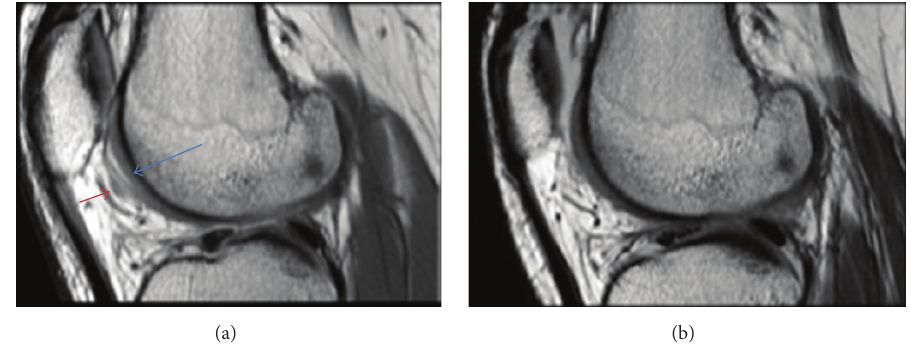
Figure 7: (a) Sagittal FIESTA image showing a grade 2 cartilage defect (blue arrow) with FNMHF (red arrow). (b) Follow-up MRI 2 years later showing healed cartilage defect and absent synovial